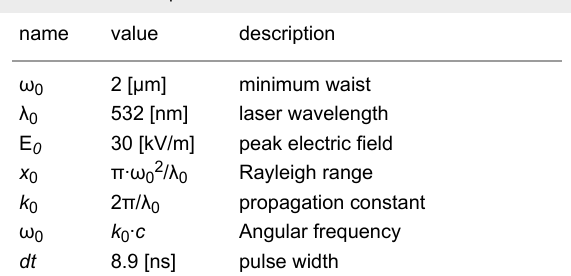
Table 1: Simulation